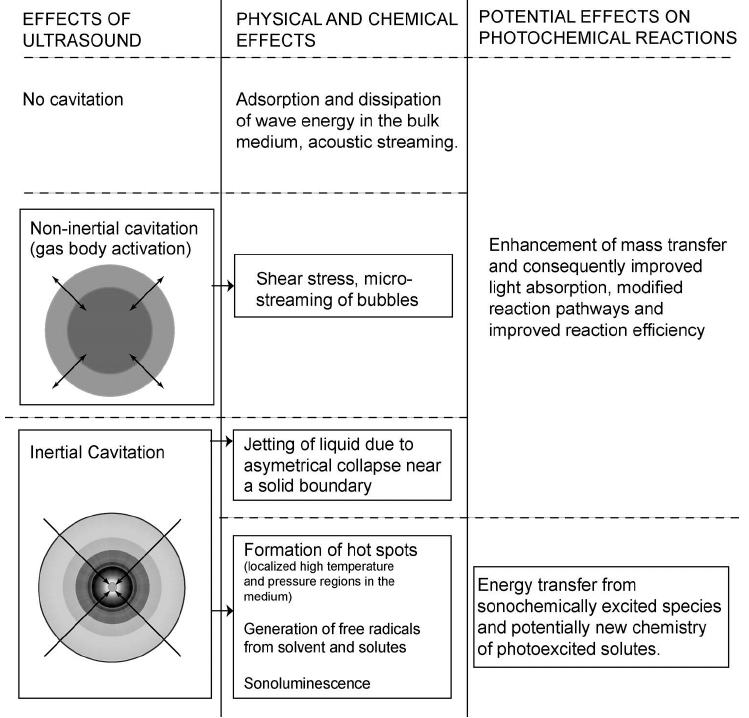
Figure 2. Interaction of ultrasound effect with photochemical reactions. Reprinted from [6] with permission of Springer.